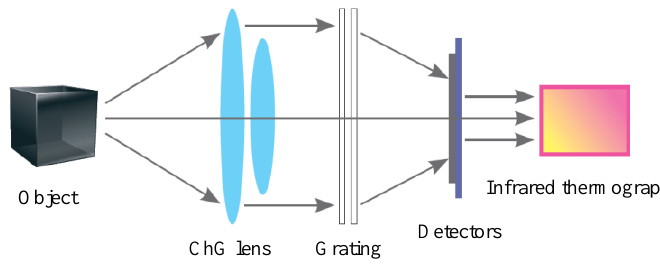
Figure 2. Schematic diagram of thermal imaging system [30].